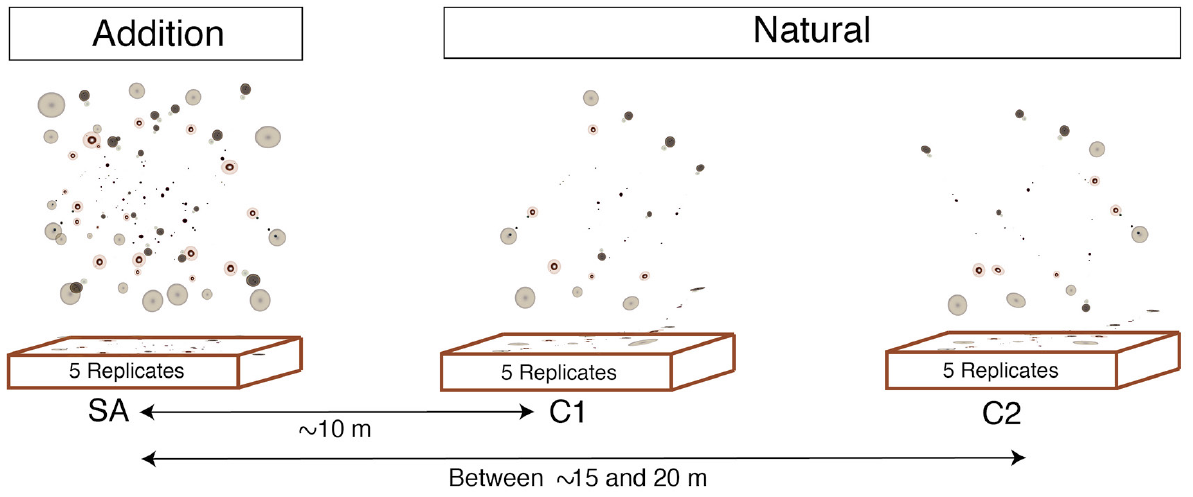
Fig. 2. – Diagram showing the experimental design of sediment additions in an in situ experiment in Capurganá Bay. Three treatments were used: sediment addition and two natural conditions, one up to 10 m distance from the sediment addition (control 1) and one between 15 and 20 m distance from the sediment addition (control